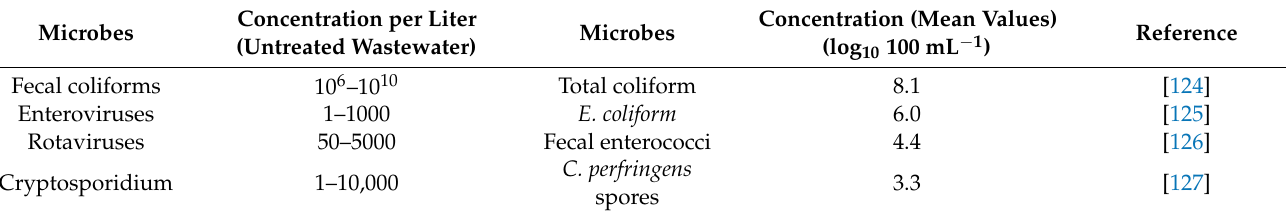
Table 9. Micro-organism and fecal presence in household untreated graywater